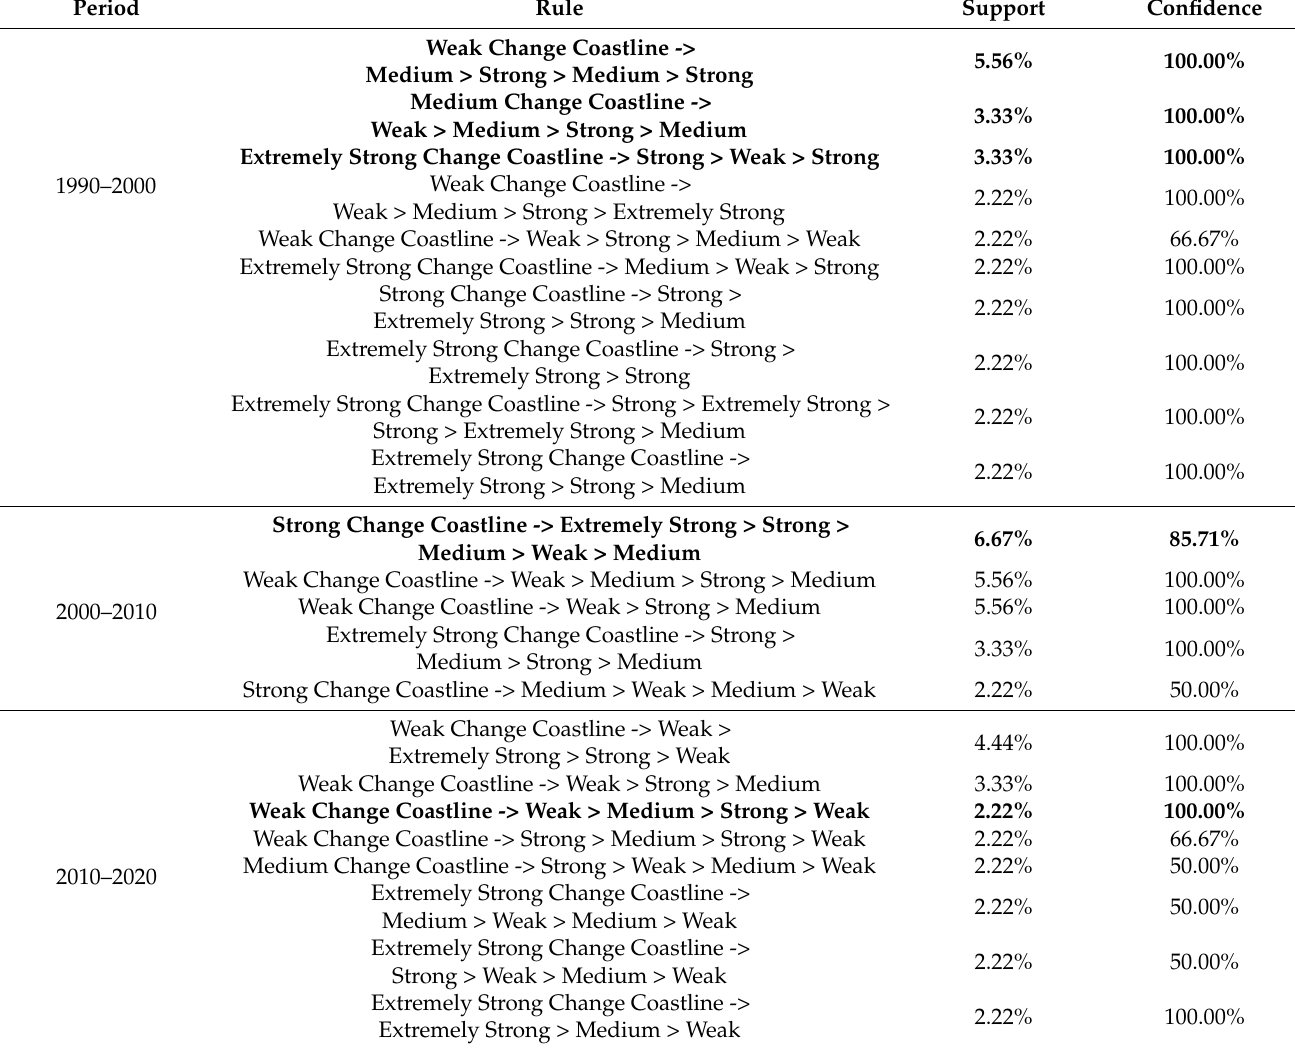
Table 5. Association rules between the coastline change and land development intensity in Yantai.